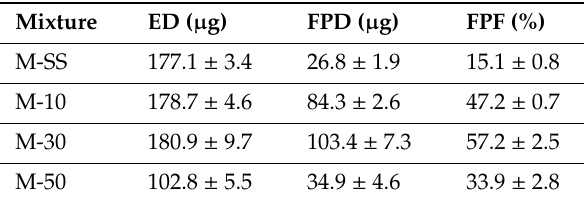
Table 3. In Vitro deposition tests—emitted dose (ED), fine particle dose (FPD), and fine particle fraction (FPF) of salbutamol sulphate from ternary mixtures of α -lactose monohydrate (L α · H 2 O), salbutamol sulphate (SS), and variable percentages (10%, 30%, and 50% w / w) of micronized lactose in comparison with a binary mixture containing no micronized lactose (M-SS). Mean values ± standard deviation ( n =